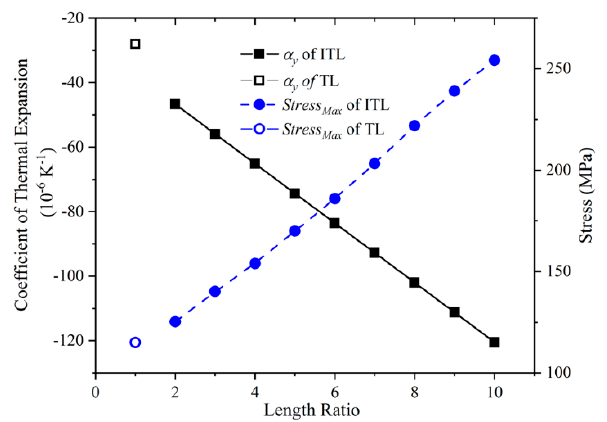
Figure 5. The Y-direction CTE and the maximum stress of the ITL with the varying length ratio L/r and these of the triangular lattice